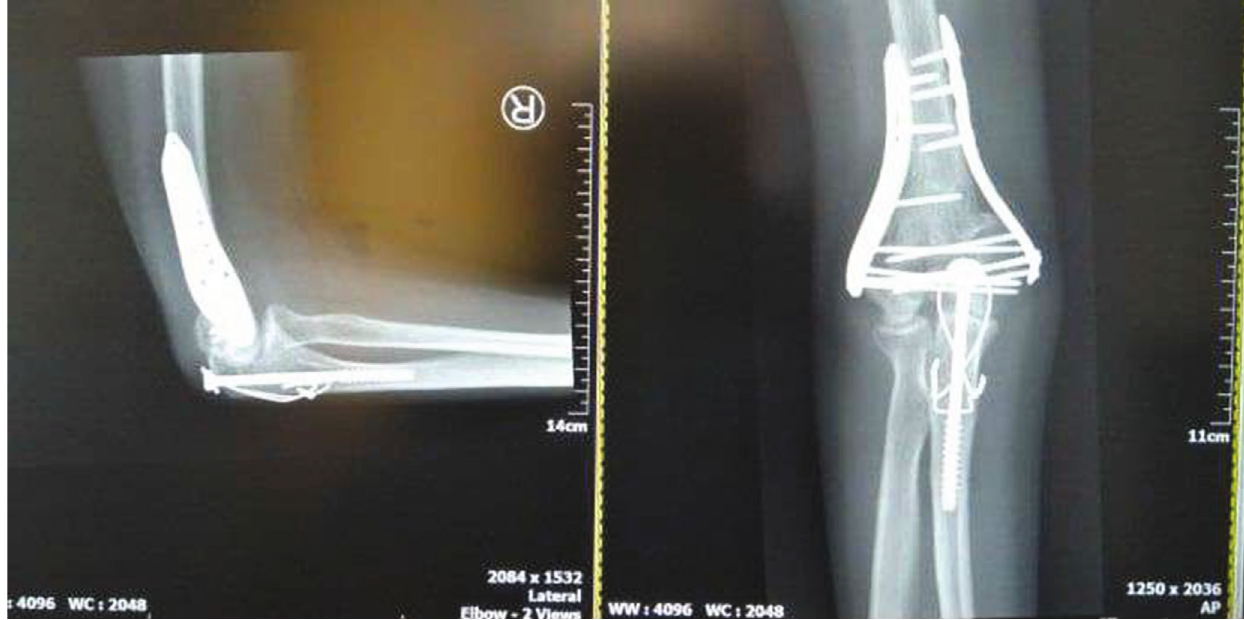
Figure 4: X-rays of the elbow six months